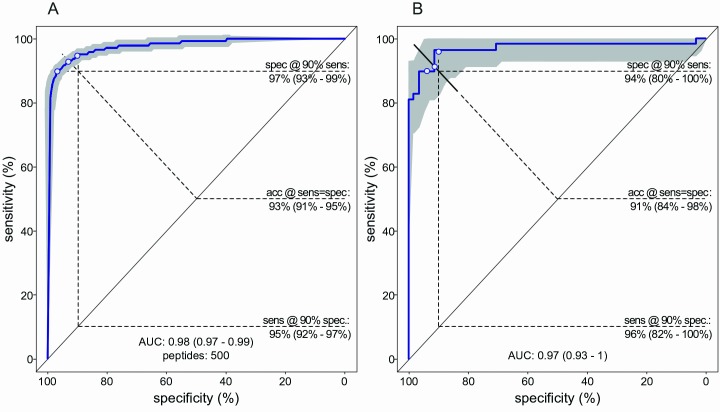
Performance of IST in distinguishing T. cruzi seropositive from seronegative donors.(A) Receiver Operating Characteristic (ROC) curve for the 2015 training cohort. The blue curve was generated by calculating the median of out-of-bag predictions in 100 four-fold cross-validation trials. (B) ROC curve for the 2016 verification cohort. The blue curve was generated by applying the training set-derived algorithm to predict the 2016 samples. Confidence intervals (CI), displayed in gray and numerically provided in parentheses, were estimated from the variation across cross-validation trials in the training cohort, and estimated by the DeLong method [53] in the verification cohort. sens = sensitivity, spec = specificity, acc = accuracy.